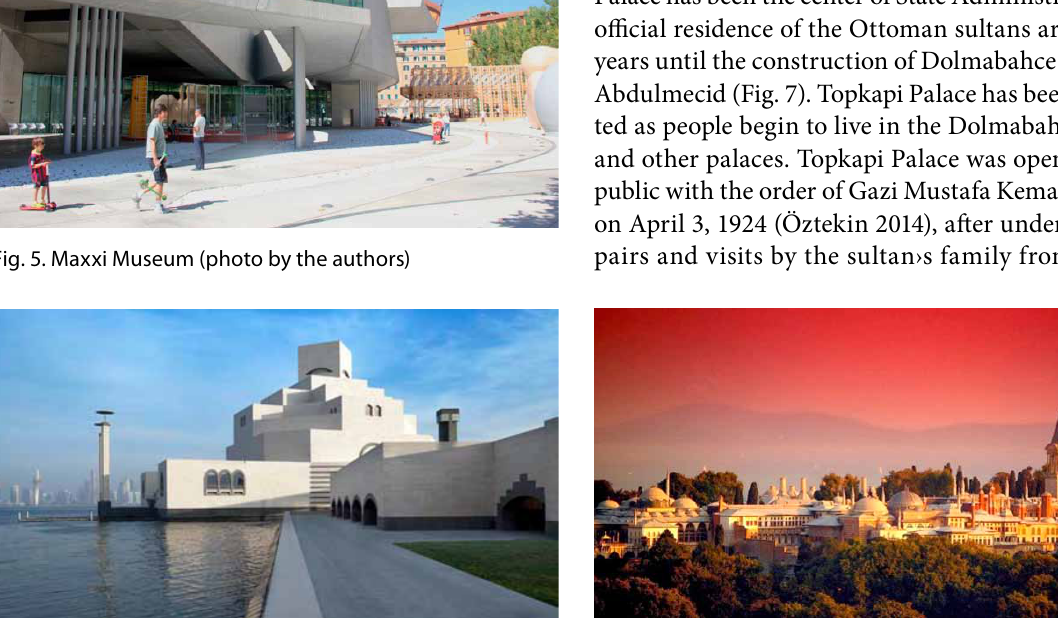
fig. 6. Museum of Islamic art in Doha (www.e-architect.co.uk) fig. 7. Topkapi Palace Museum